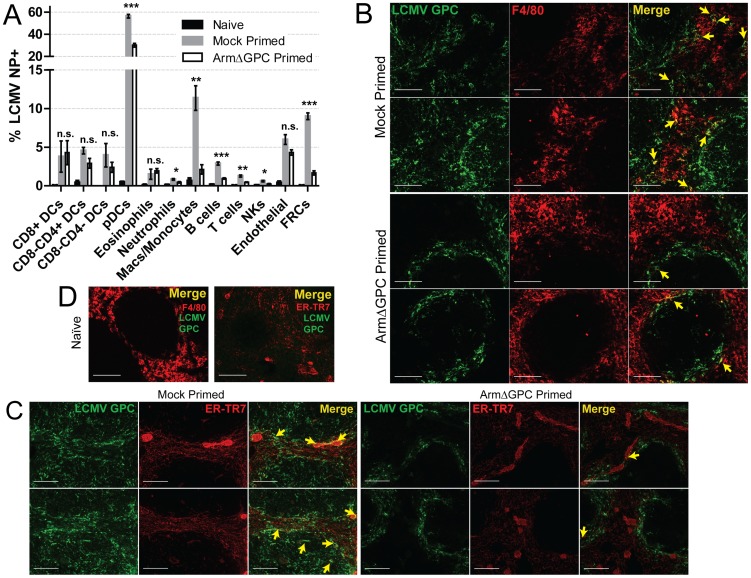
Priming with ArmΔGPC changes cellular tropism during Cl13 infection.C57Bl6/J mice (n = 4/group) were primed and infected as in Fig. 5 and spleens were harvested at 72 hours post-infection. A) Spleens were incubated with 1 mg/mL collagenase D/100 µg DNaseI and manually dissociated through 100 µm nylon screens. Cells were identified by flow cytometry through staining and gating with the following fluorescently conjugated anti-mouse antibodies: DCS: lin-(CD90.2/CD19), CD11chigh; pDCs: lin-, CD11c+, SiglecH+, PDCA-1+, B220+; Eosinophils: lin-, CD11b+, Ly6G-, Ly6clow, SSC-Ahigh; Neutrophils: lin-, CD11b+, F4/80-, Ly6G+; Macs/Monocytes: lin-, CD11b+, Ly6G-, Ly6c+, F4/80+; B cells: B220+, CD3-, CD8-, NK1.1-; T cells: B220-, NK1.1-, CD3+, CD8+ or CD4+; NK cells: CD3low, B220-, NK1.1+; Endothelial cells: lin-, CD45-, gp38+, CD31+; FRCs: lin-, Cd45-, gp38+, CD31-, CD35low. Representative data from one of two independent experiments are shown with SEM calculated and displayed using GraphPad Prism software. Statistical analysis (unpaired t-test) is shown between mock primed and ArmΔGPC primed Cl13 infected groups. NS, not significant; *p<0.05; **p<0.005; **p<0.0005. B–D) Spleens treated as in Fig. 5 and 6 µm sections were stained with guinea pig serum to LCMV GPC (Green) and antibodies used to visualize mature macrophages (F4/80, red, B and D) and fibroblastic reticular cells (ER-TR7, red, C and D). Yellow arrows indicate areas of costaining. The two examples from each staining are from different mice. D) Spleens of naïve mice are shown for comparison and specificity of LCMV serum. White bars indicate 100 µm. All micrographs are representative examples of micrographs from two independent experiments.